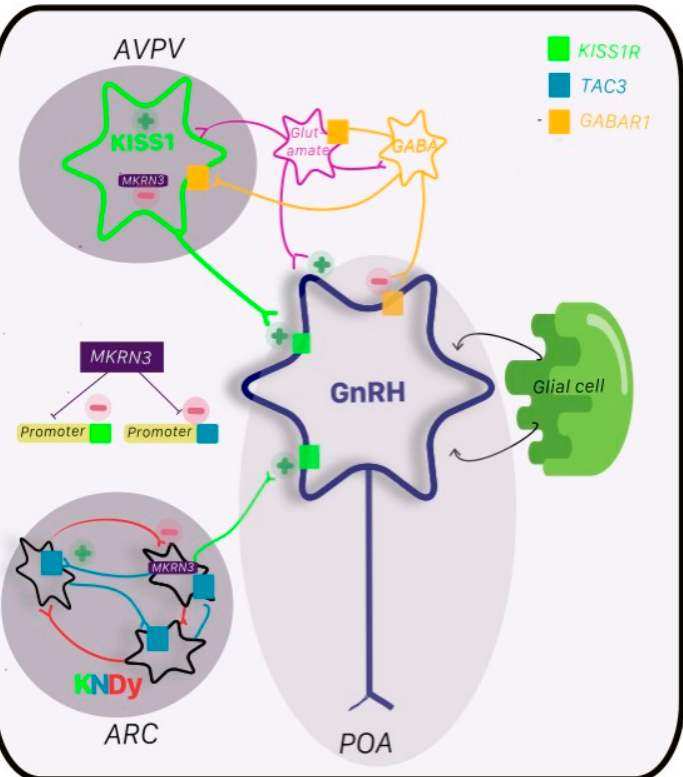
Figure 1. Regulation of GnRH network. GnRH neurons (navy) reside primarily in the preoptic area (POA) and form the GnRH pulsatility that is the basis of subsequent pubertal changes downstream in the HPG axis. The KNDy network in the arcuate nucleus (ARC) is known as the pulse generator for GnRH, which is inhibited by dynorphin (Dy; red) and stimulated by neurokinin B (NKB; blue) via its receptor TAC3 (blue box) and kisspeptin (green) and its receptor KISSR1 (green box). Kisspeptin is also found in the anteroventral periventricular nucleus (AVPN) with stimulatory input from glutamate (pink) and inhibitory input from GABA (orange) and its receptor GABA A R1 (orange box). The major antagonist to kisspeptin activity, and hence GnRH, is via makorin ring finger protein (MKRN3; purple). MKRN3 inhibits promoters of KISS1 and TAC3, and hence, suppresses transcription of kisspeptin and NKB. Glial cells also play a critical role, as do other neuroendocrine regulators including feedback from the pituitary and gonads (not shown).